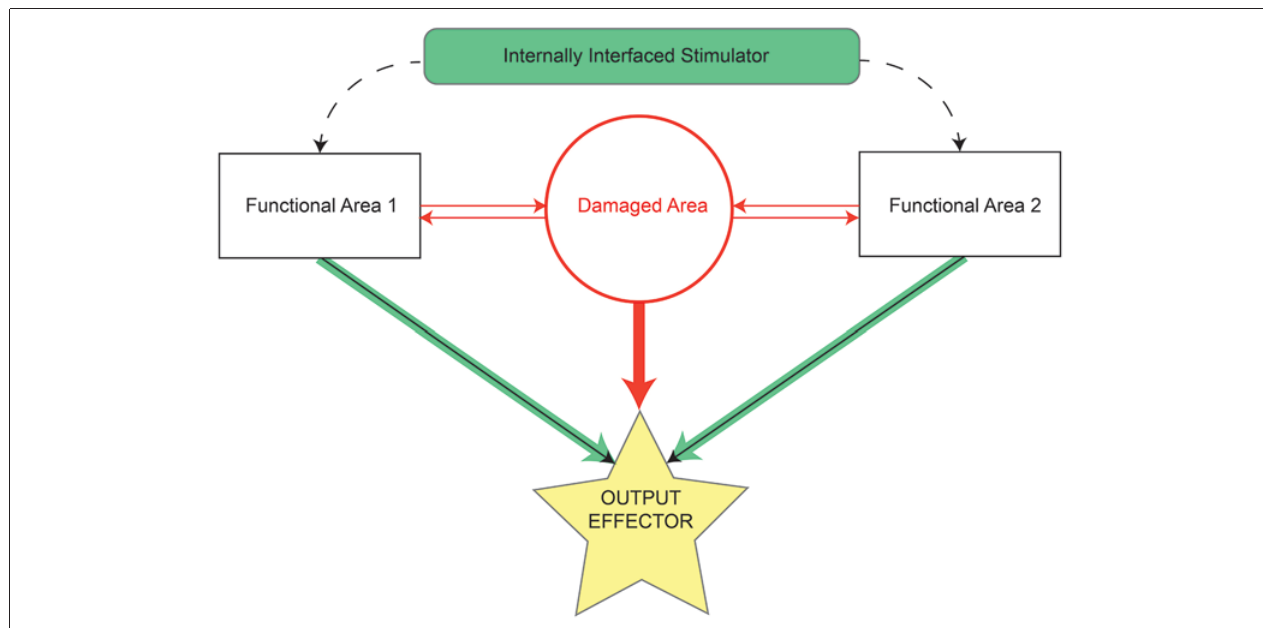
FIGURE 3 | Schematic by which internally contained stimulation devices restore lost function resulting from damaged or missing tissue. Before damage, the area of interest (red circle) and functionally related areas (rectangles) relay information between each other and effectors (solid arrows) of some output task (yellow star). The majority of information in controlling task output initially comes from the damaged area (thick red arrow), but may also arrive, although to a lesser extent, from functionally related areas (thin black arrows). Following injury, connections to and from the damaged area are lost (all red elements). The stimulation device serves as a direct bridge between functional areas, allowing strengthened output (thick green arrows) from those areas to the output effectors and thereby restoring some degree of lost